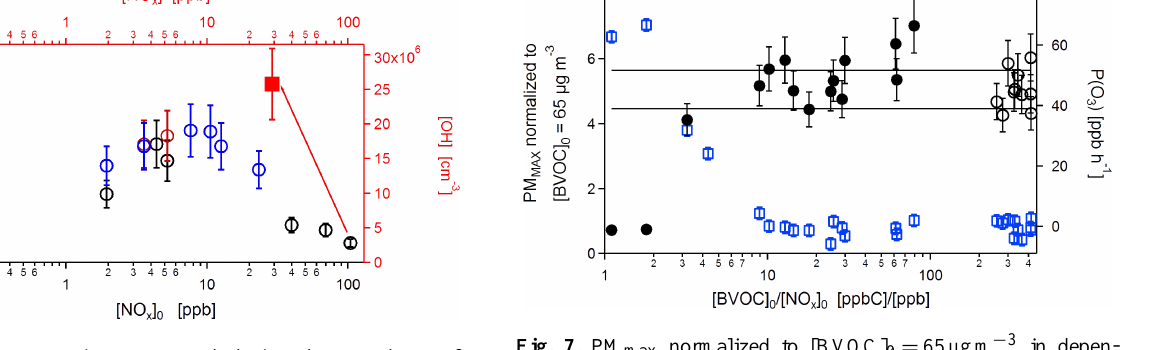
Fig. 6. OH concentrations measured during the first hour af- ter switching on the TUV lamp in dependence of [NO x ] 0 (note logarithmic scale of x axis). The error in OH concentrations is estimated to be ± 20%. Brown circles represent OH mea- sured at [BVOC] 0 <55µgm − 3 , blue circles those measured at 55 <[BVOC] 0 <65µgm − 3 and black circles those measured at [BVOC] 0 >65µgm − 3 . The red square shows the OH concentra- tion measured for the highest NO x addition ([NO x ] 0 = 103.5ppb), 5h after ignition of the TUV lamp. After that time new particle for- mation was observed, [O 3 ] had increased to 85ppb and [NO x ] had decreased to 26ppb.